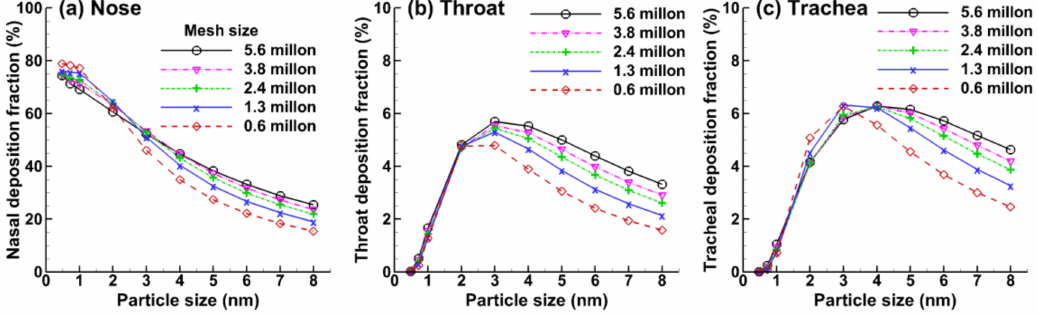
Figure 2. Mesh sensitivity analysis of the predicted sub-regional deposition fractions in ( a ) nose; ( b ) throat; and ( c )